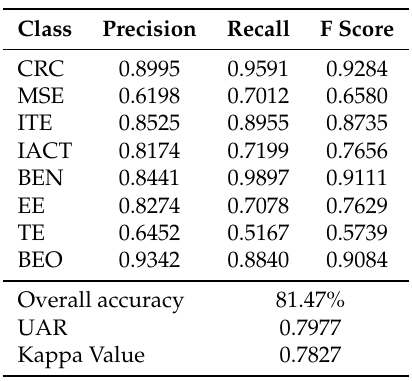
Table 6. Accuracy parameters result for eight building classification with a 2 m